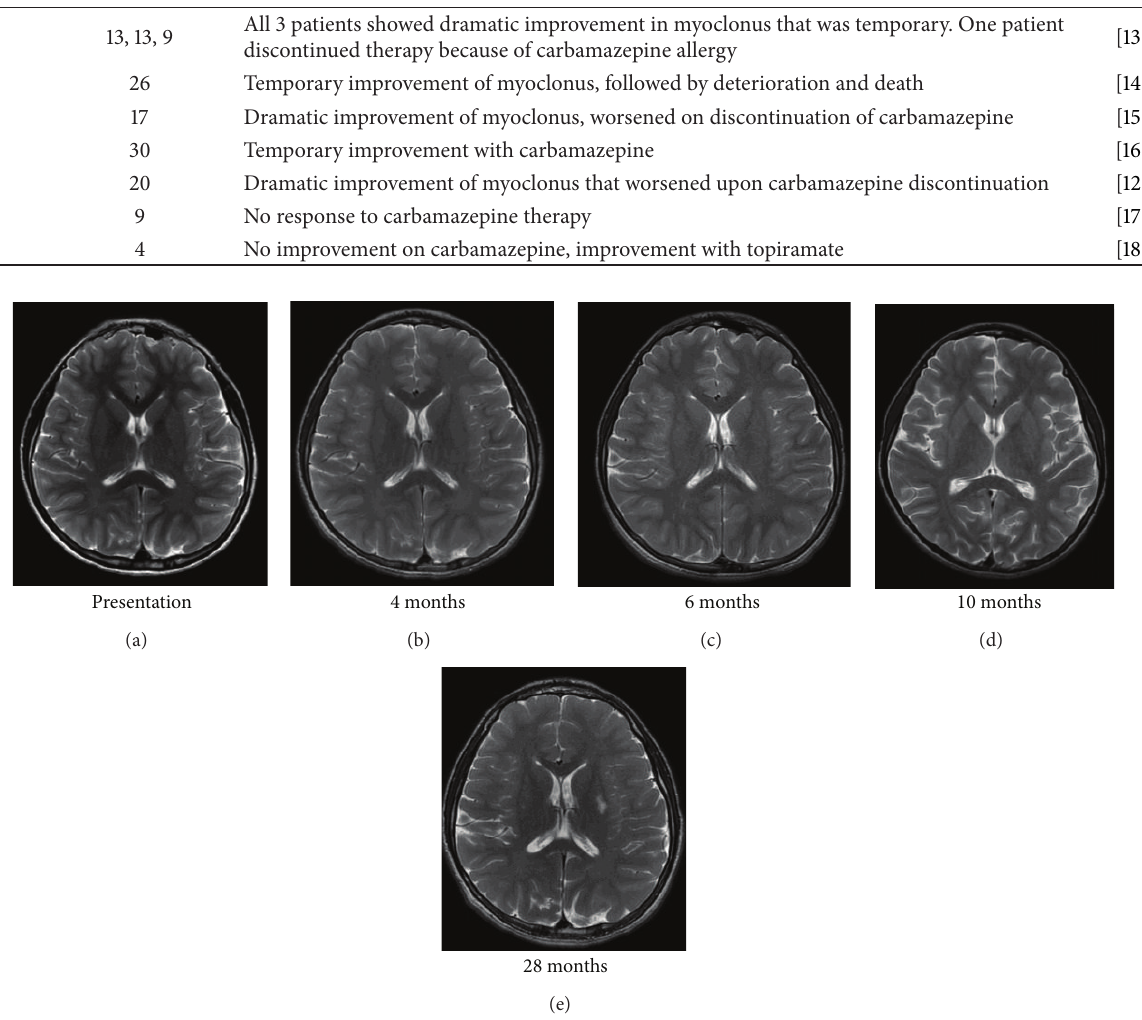
Figure 2: Time course of SSPE by MRI reveals progressive cortical and subcortical white matter volume loss resulting in enlargement of the lateral